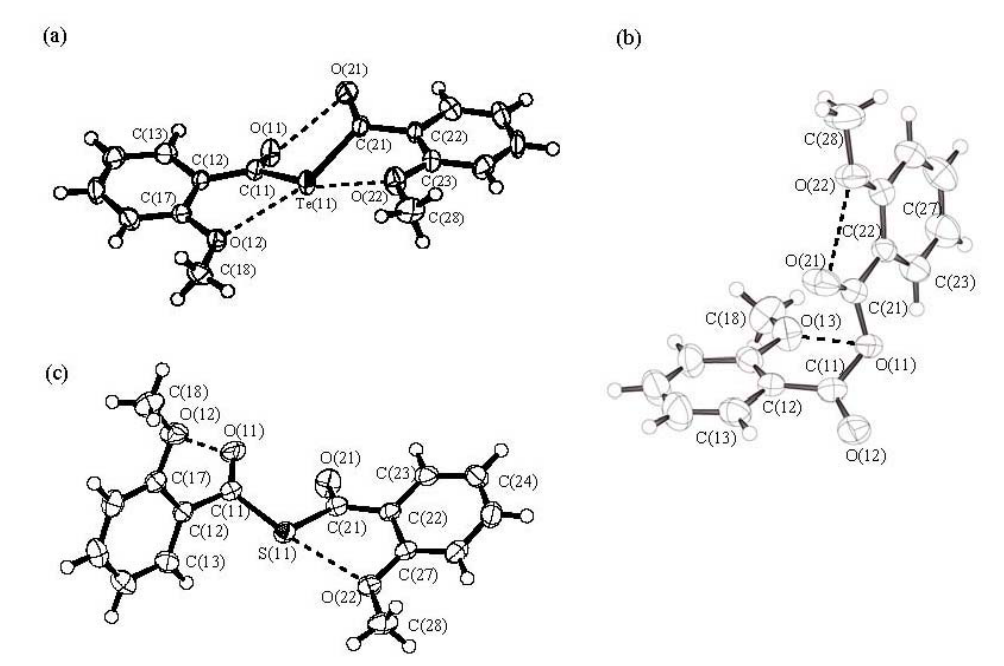
Figure 1. ORTEP drawings of (a) bis(2-methoxybenzoyl) telluride ( 4f ), (b) 2-methoxy- benzoic anhydride ( 5 ) and (c) bis(2-methoxybenzoyl) sulfide ( 6 ). The thermal ellipsoid plots represent 50%